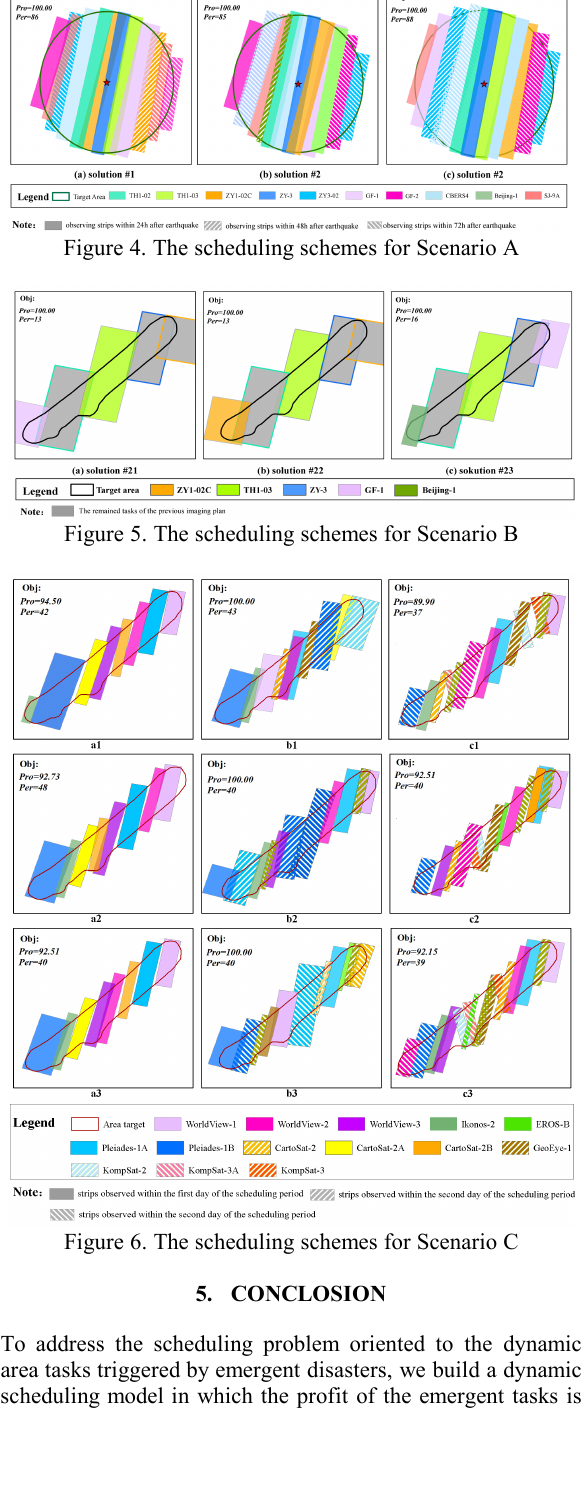
Figure 2. The target area